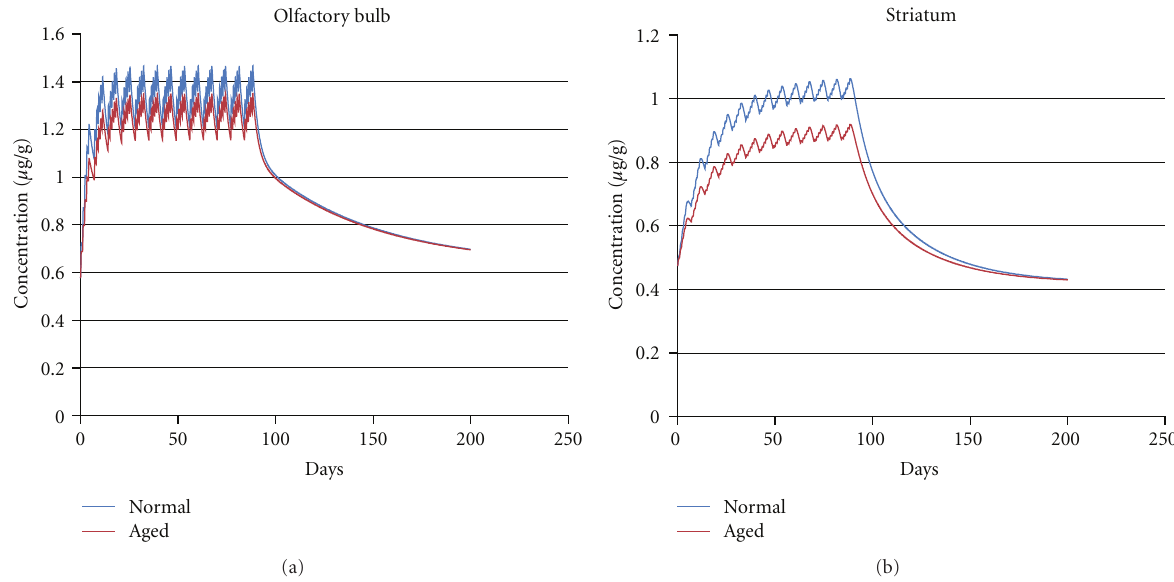
Figure 4: Simulated olfactory bulb (L) and striatum (R) manganese concentrations in adult and aged (16 month old) male rats following 6hr/d inhalation MnSO 4 exposure at 0.5mg Mn/m 3 for 90 days. Model simulations for aged rats had a 25% decrease in minute volume consistent with reported reduction in pulmonary function [22,